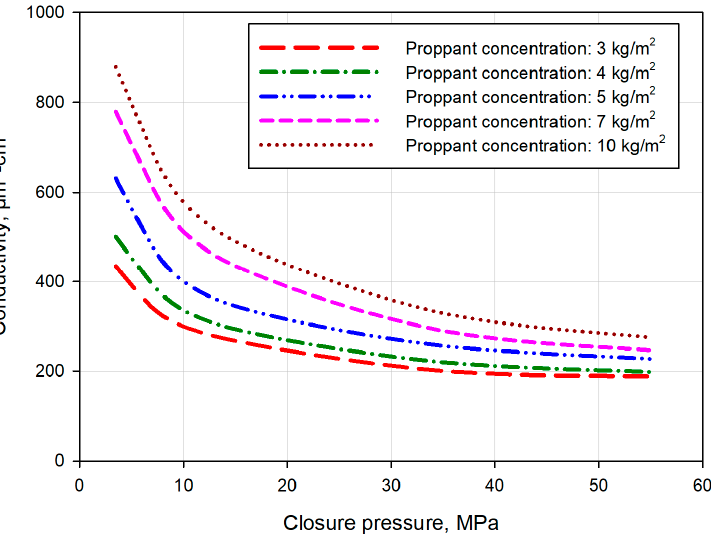
Figure 10. Conductivity evolution of H-shaped intersecting pattern fractures with different proppant concentrations.